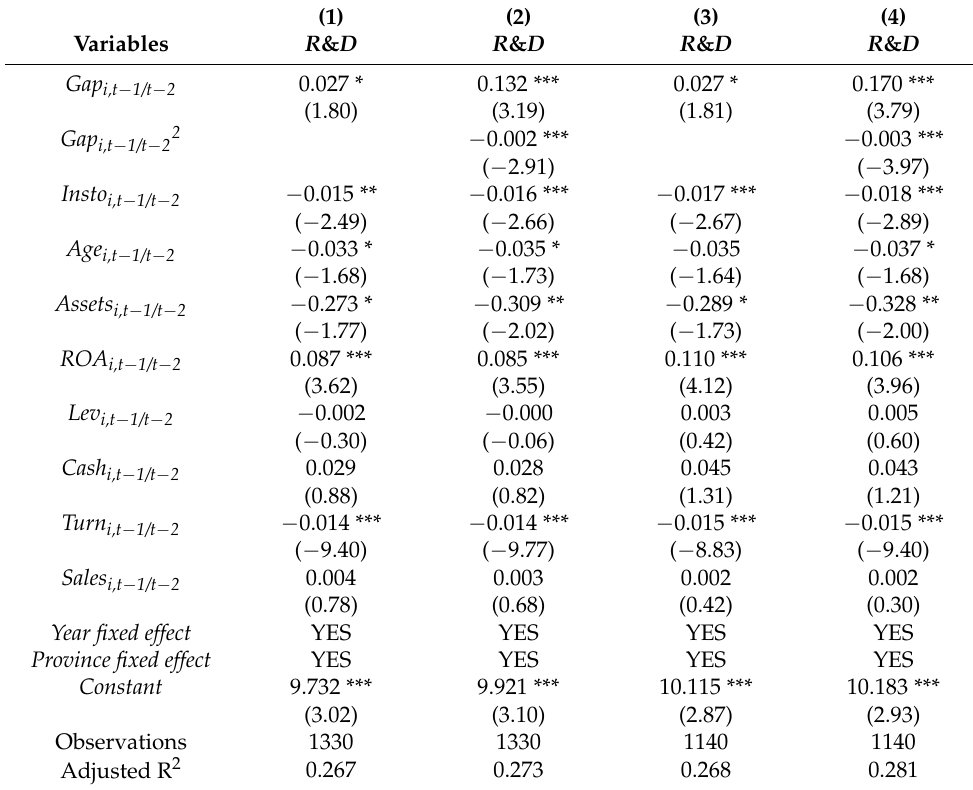
Table 5. Robustness test: one- and two-year lag of explanatory